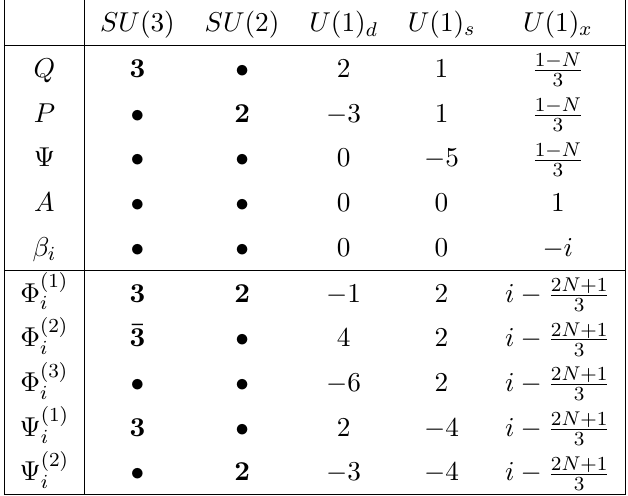
Table 9 . Transformation rules under the global symmetry of the 2 d matter fields of the dual theories coming from the dimensional reduction of theory T 4d